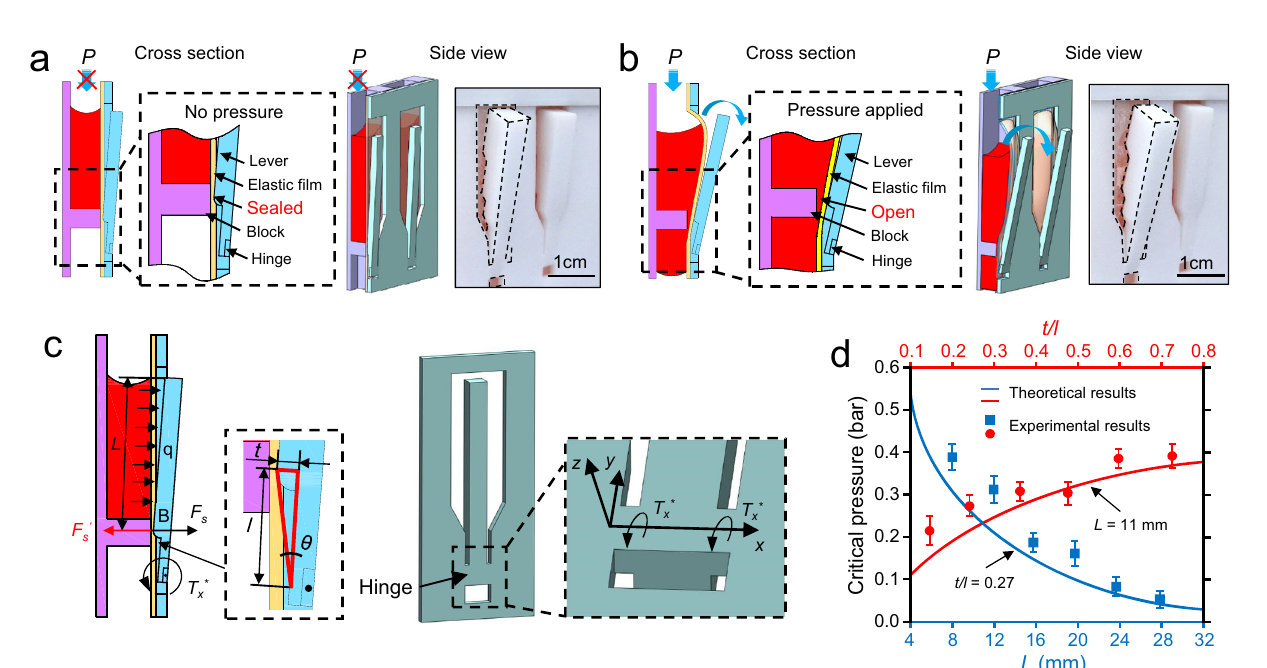
FAST. b Expandedview schematic diagram of the FAST-POCT platform. c Photo of the platform next to a US quarter